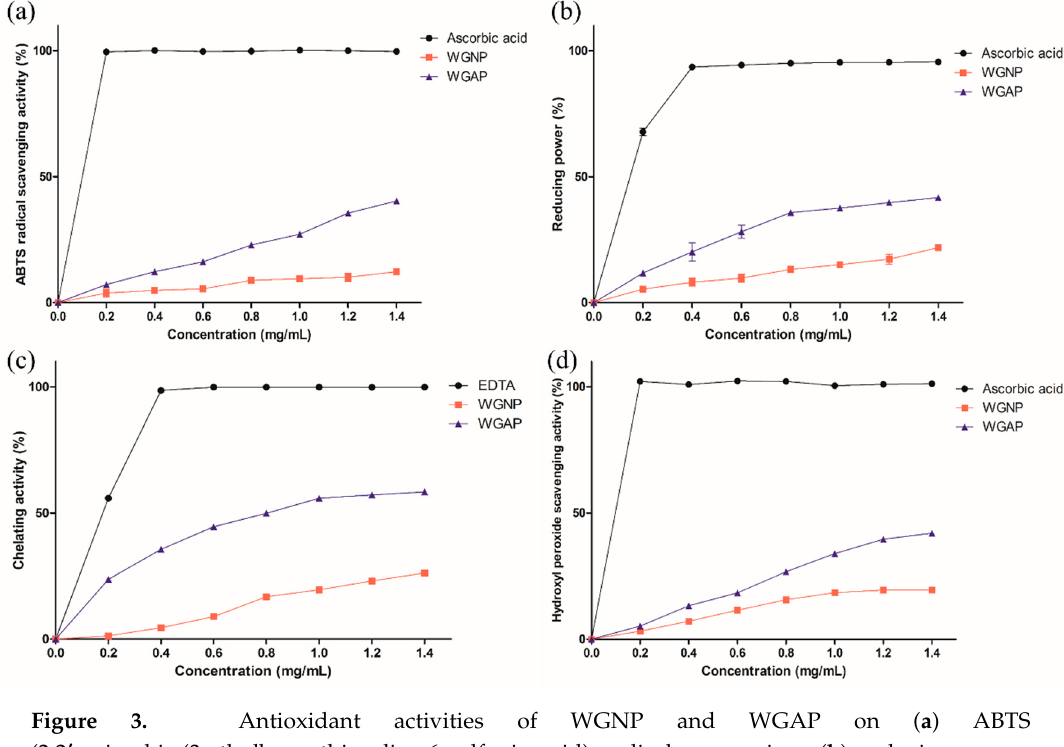
Figure 3. Antioxidant activities of WGNP and WGAP on ( a ) ABTS (2,2 ′ -azino-bis-(3-ethylbenzothiazoline-6-sulfonic acid) radical scavenging, ( b ) reducing power, ( c ) ferrous chelating, and ( d ) hydroxyl peroxide scavenging activities.